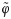
Modeling results.Exceedance probabilities (φ) resulting from the random-effects family-wise model comparison. (A) Dirichlet-Categorical (DC) model, Hidden Markov Model (HMM) and null model family comparison, thresholded at φ > 0.99 and applied for data reduction at all further levels. (B) Family comparison within the winning DC family, thresholded at φ > 0.95: first and second order transition probability models (TP1, TP2). (C) Family comparison within the winning DC family, thresholded at φ > 0.95: first order transition probability (TP1), alternation probability (AP) and stimulus probability (SP) models and applied at the final level. (D) Unthresholded protected exceedance probabilities (φ˜) resulting from model comparison of surprise models within the winning DC TP1 family: Large discrete topographies show the electrode clusters of predictive surprise (PS) in red, Bayesian surprise (BS) in green and confidence-corrected surprise (CS) in blue. White asterisks indicate φ˜>0.95 of single electrodes. Small continuous topographies display the converged variational expectation parameter mβ. This parameter may be interpreted as a β weight in regression, indicating the strength and directionality of the weight on the model regressor that maximizes the regressor’s fit to the EEG data (see S2 Appendix).